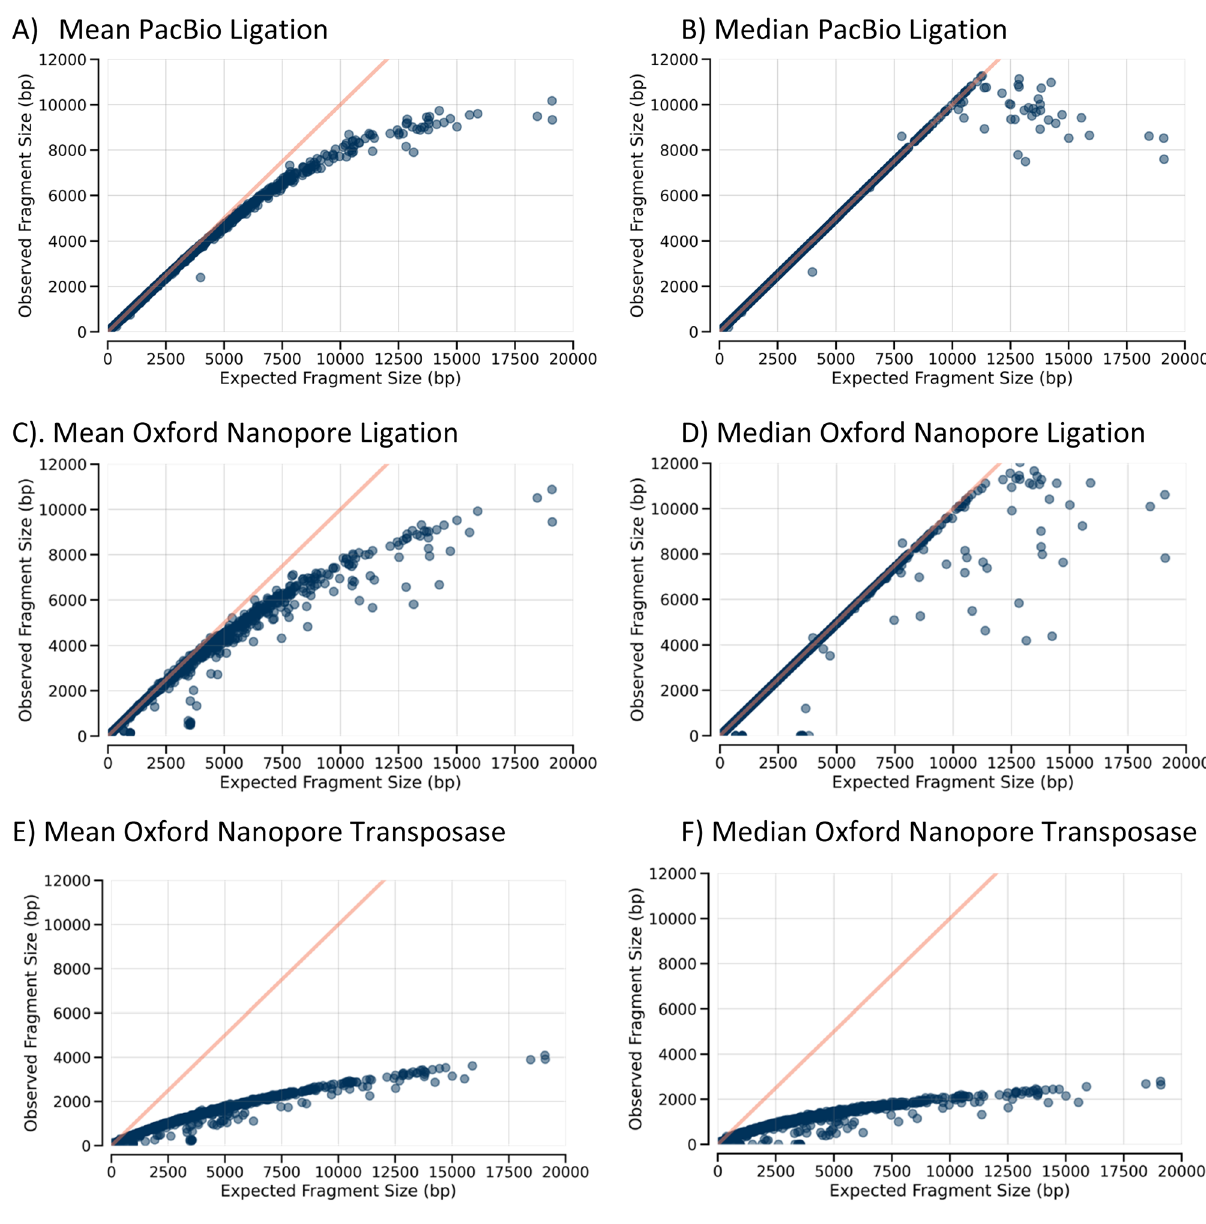
Figure 1. Observed sizes versus expected sizes for XmnI digests. Expected versus observed lengths of XmnI- cut E. coli stationary phase DNA. The expected length of XmnI fragments prepared using PacBio library method 2.1 derived from the E. coli genome sequence is plotted on the X-axis versus the mean ( A ) or median ( B ) size of observed fragments from stationary phase DNA. The mean and median for the same DNA prepared using the Oxford Nanopore ligation method ( C and D ) and the transposase method ( E and F ) are also